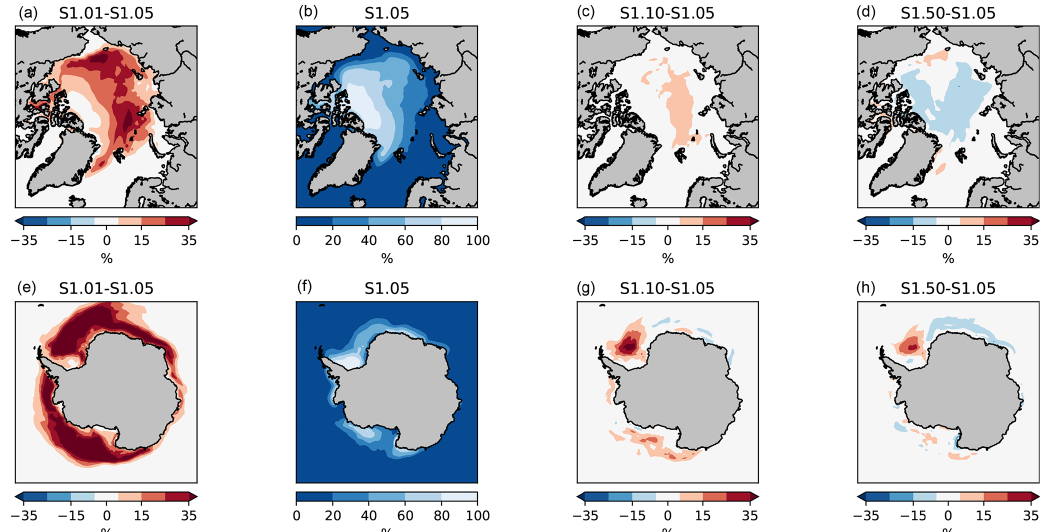
Figure 5. Sea ice concentration in the Arctic in August (top) and in the Antarctic in February (bottom), averaged over 1995–2014. Experiment S1.05 and differences with selected experiments of the first set are shown.